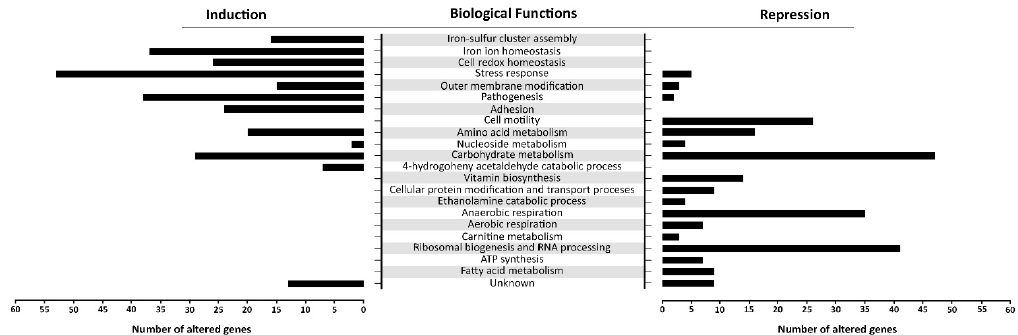
Figure 6. Gene ontology (GO) enrichment analysis. The figure portrays the most altered biological functions of S . Enteritidis during the H 2 O 2 treatment. In the GO analysis were included operons /